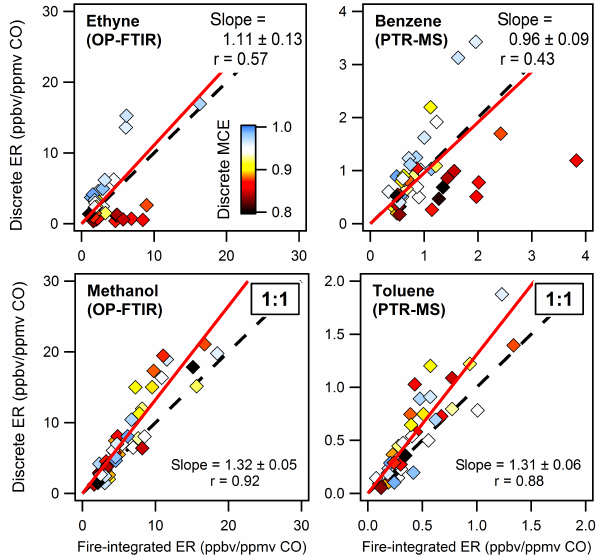
Figure 3. Correlation plots of the discrete versus fire-integrated emission ratios (ER) for ethyne and methanol measured by the OP- FTIR and benzene and toluene measured by the PTR-MS. Each data point represents one biomass burn and is colored by the modified combustion efficiency (MCE) corresponding to the discrete sam- pling times of the GC-MS. MCE values near unity are associated with flaming combustion and lower MCE values are associated with smoldering combustion. The linear 2-sided regression lines forced through the origin are shown as red lines and the 1:1 ratio is shown by the dashed